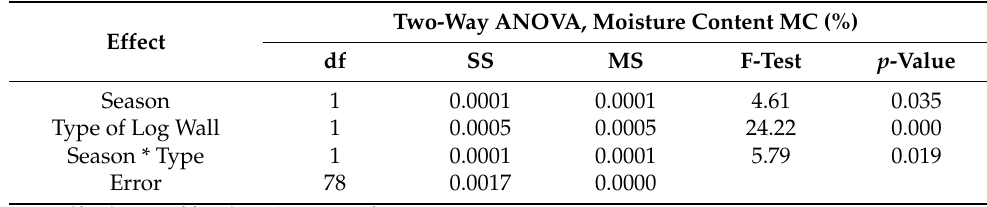
Figure 13. The Moisture Content of the Fiberboard Insulation between Studs in the Wall without Vapor Barrier. Statistical analysis of STEICO Flex part 1 was done in STATISTICA ® software, results shown in Table 4 and Figure 14. Table 4. Results of ANOVA for the insulation STEICO Flex part 1 width 45